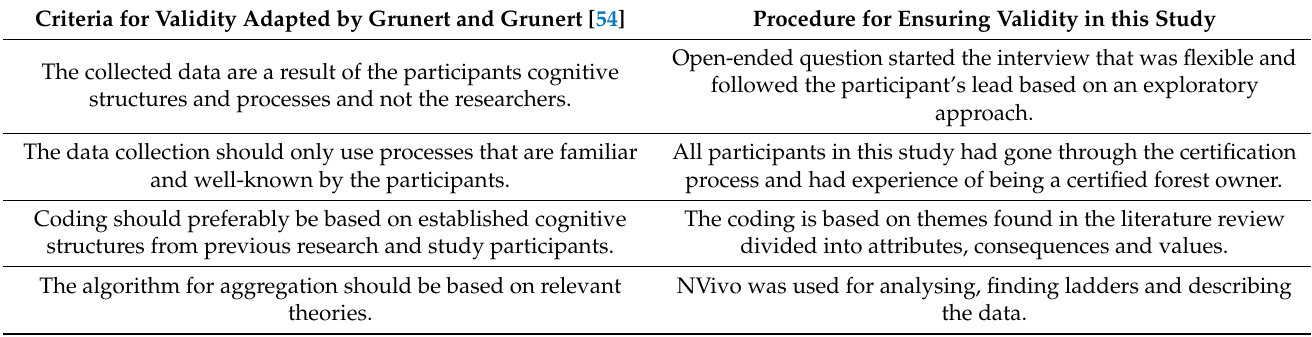
Table 2. Criteria for validity in laddering data collection and